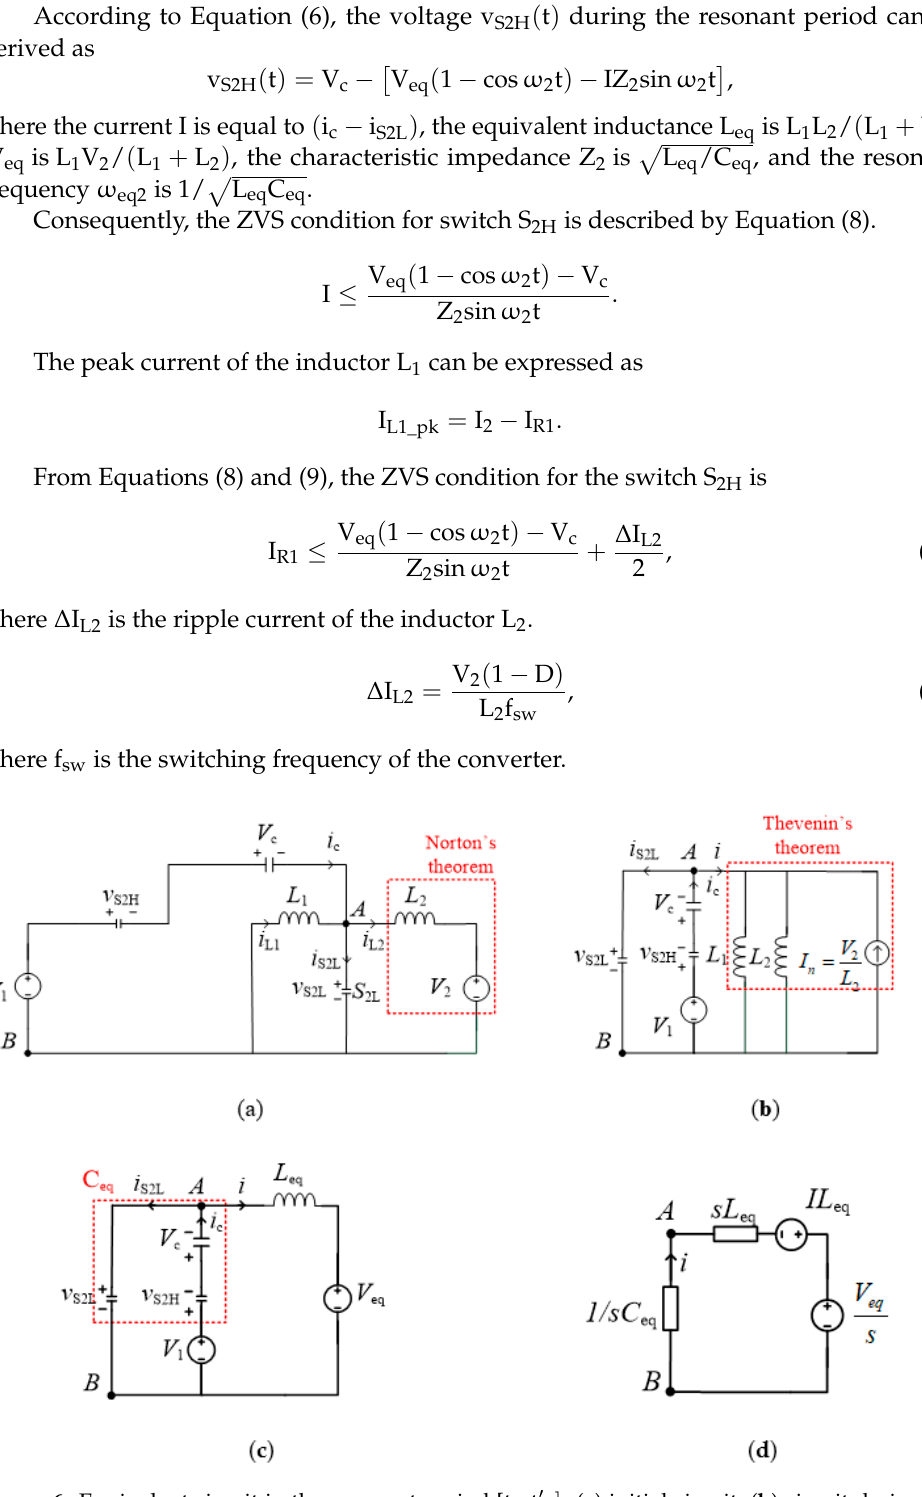
Figure 6. Equivalent circuit in the resonant period [t 4 ,t (cid:48) 4 ] : ( a ) initial circuit; ( b ) circuit derivation with Norton’s theorem; ( c ) circuit derivation with Thevenin’s theorem; ( d ) equivalent circuit with Laplace transforms.